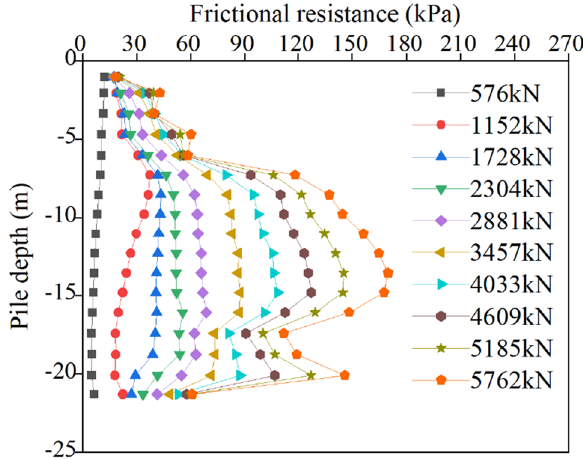
Figure 9. Friction resistance of the normal uplift